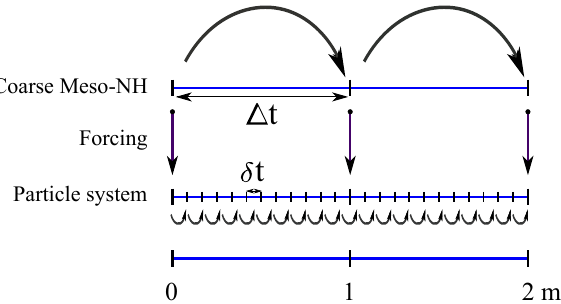
Figure 4. The different timescales used in this work. The forcing is applied at each coarse time step (cid:49)t . Between two coarse time steps, particle evolution is performed with a fine time step δt and sub-grid processes are